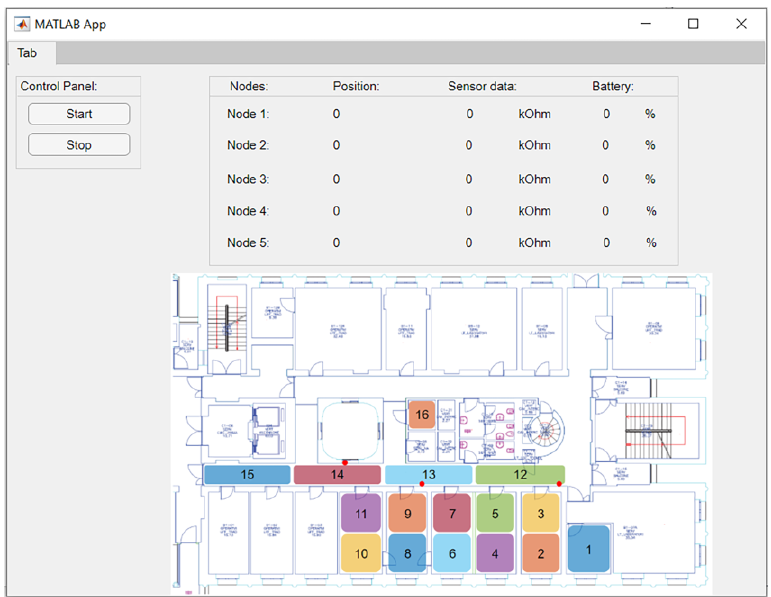
Figure 4. The MATLAB script GUI is designed for five sensing nodes enumerated from 1 to 5. When one of the five sensing nodes starts to advertise, the GUI shows position, area, sensor data, and battery level.